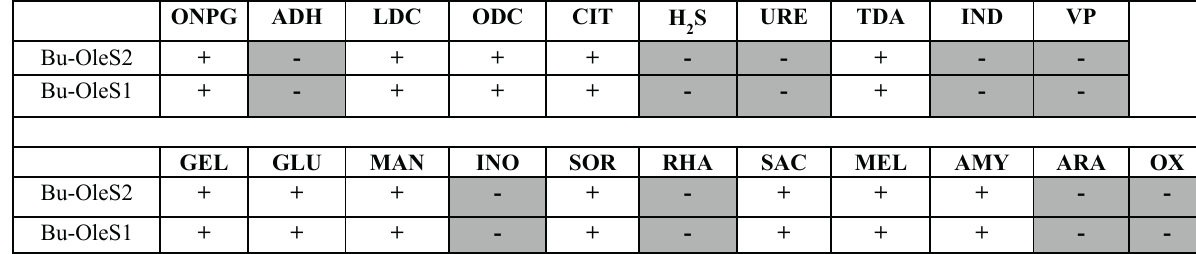
Figure 2. Results from the API 20E test for two Serratia marcescens isolates (Bu-OleS2 and Bu-OleS1). (ONPG: β-galactosidase; ADH: argi- nine dihydrolase; LDC: lysine decarboxylase; ODC: ornithine decarboxylase; CIT: utilization of citrate; H2S: hydrogen sulfide; URE: urease;